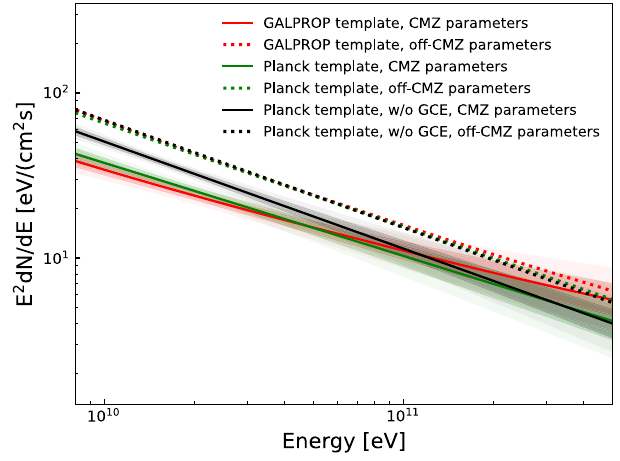
Fig. 1 Energy fl ux of γ -ray from neutral pion decays in the CMZ region. Colored regions with solid lines (red and green) show the fi tted results assuming different spatial templates, i.e., the neutral pion decay template from GALPROP and Planck dust opacity template in the CMZ region. Dark and light regions are the 68 and 95% con fi dence ranges, respectively. Dotted lines show the predicted results using the off-CMZ parameters for given templates, which represent the anticipated CR sea component. The spectrum derived from the CMZ region is harder and the integrated fl ux is lower than those anticipated from the CR sea interaction. As a comparison, the black line and shaded band show the fi tting results derived with the Planck template, but without subtracting the GCE component. The dotted black line shows the anticipated result using the off-CMZ parameters in this case. Again we fi nd that the integrated fl ux in the CMZ is lower than that anticipated from the CR sea interaction. Source data are provided as a Source Data fi